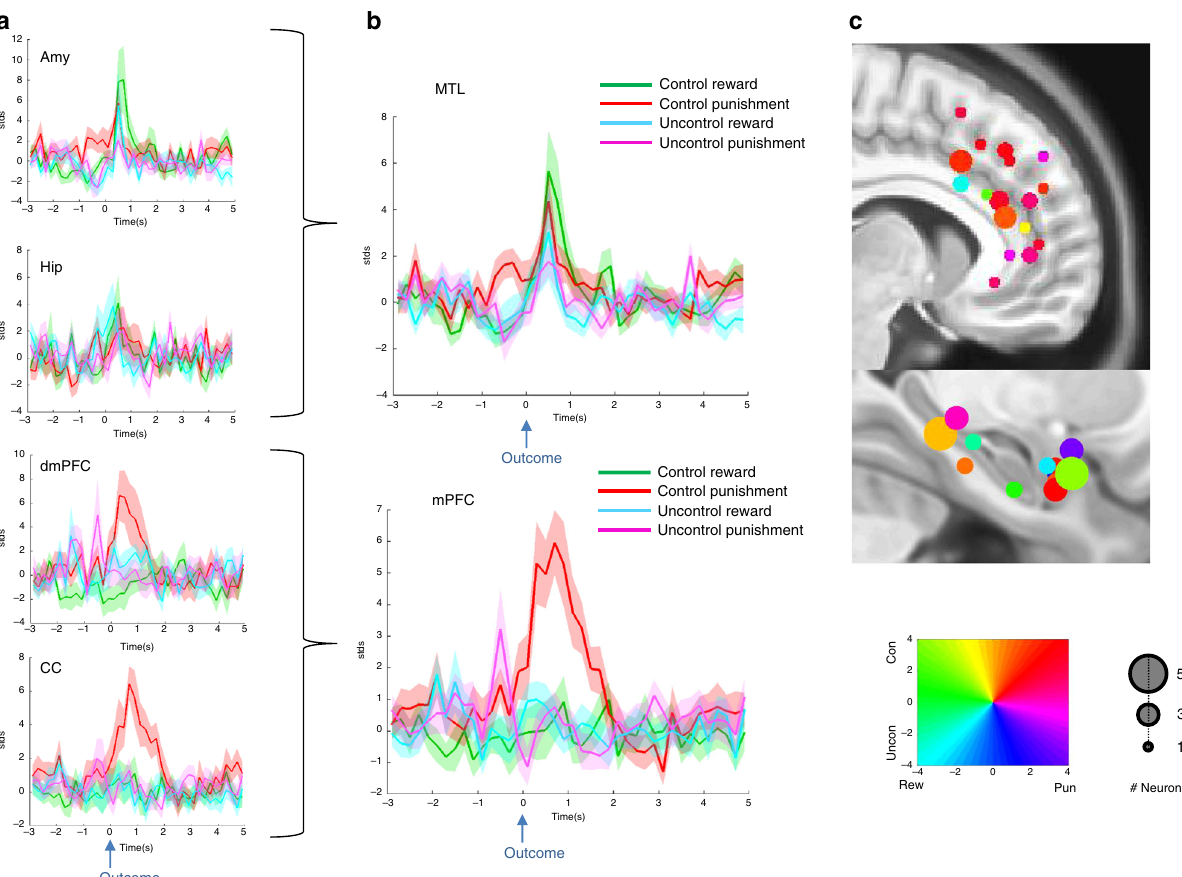
Fig. 4 Selectivity of neural time-course responses per outcome types. Average normalized FR for positively responsive neurons shown for ( a ) each of the four recording regions N = 12, 9, 11, and 22 for Amygdala, Hippocampus, dmPFC, and CC, respectively. b Combined regions in MTL and mPFC groups, N = 24 MTL and 34 mPFC neurons. Shaded area corresponds to standard error of mean (SEM). Source data are provided as a Source Data fi le. c Responsivity pro fi le projected on two sagittal atlas slices for mPFC (upper panel) and MTL (lower panel) region groups. Coloring is according to the averaged normalized FR change for each condition (coloring key is presented in lower square). Circle size corresponds to the number of neurons from each contact groups, from 1 (smallest) to 5 (largest) (see key). Time 0 on the x -axis represents the timing of outcome (coin or ball hit the avatar). Amy amygdala, Hip hippocampus, dmPFC dorsomedial prefrontal cortex, CC cingulate cortex, MTL medial temporal lobe, mPFC medial prefrontal cortex, STDs standard deviations, Rew reward, Pun punishment, Uncon uncontrol, Con